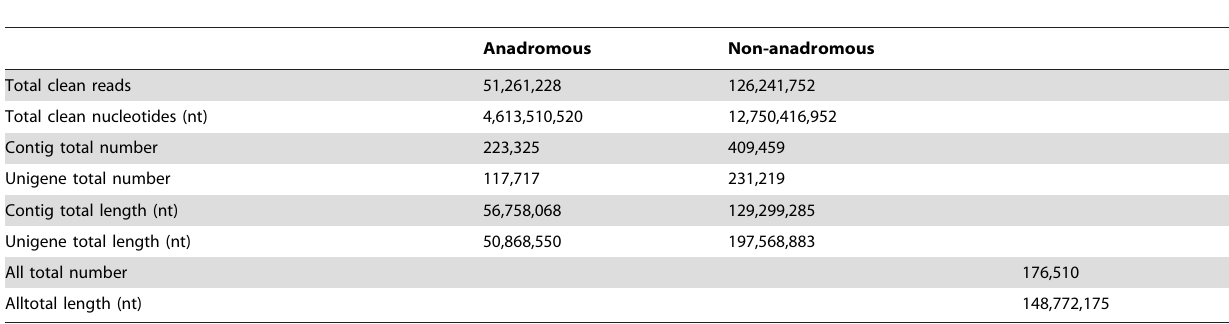
Table 1. Summary of the sequences obtained from the olfactory epithelium of anadromous and non-anadromous Coilia nasus .